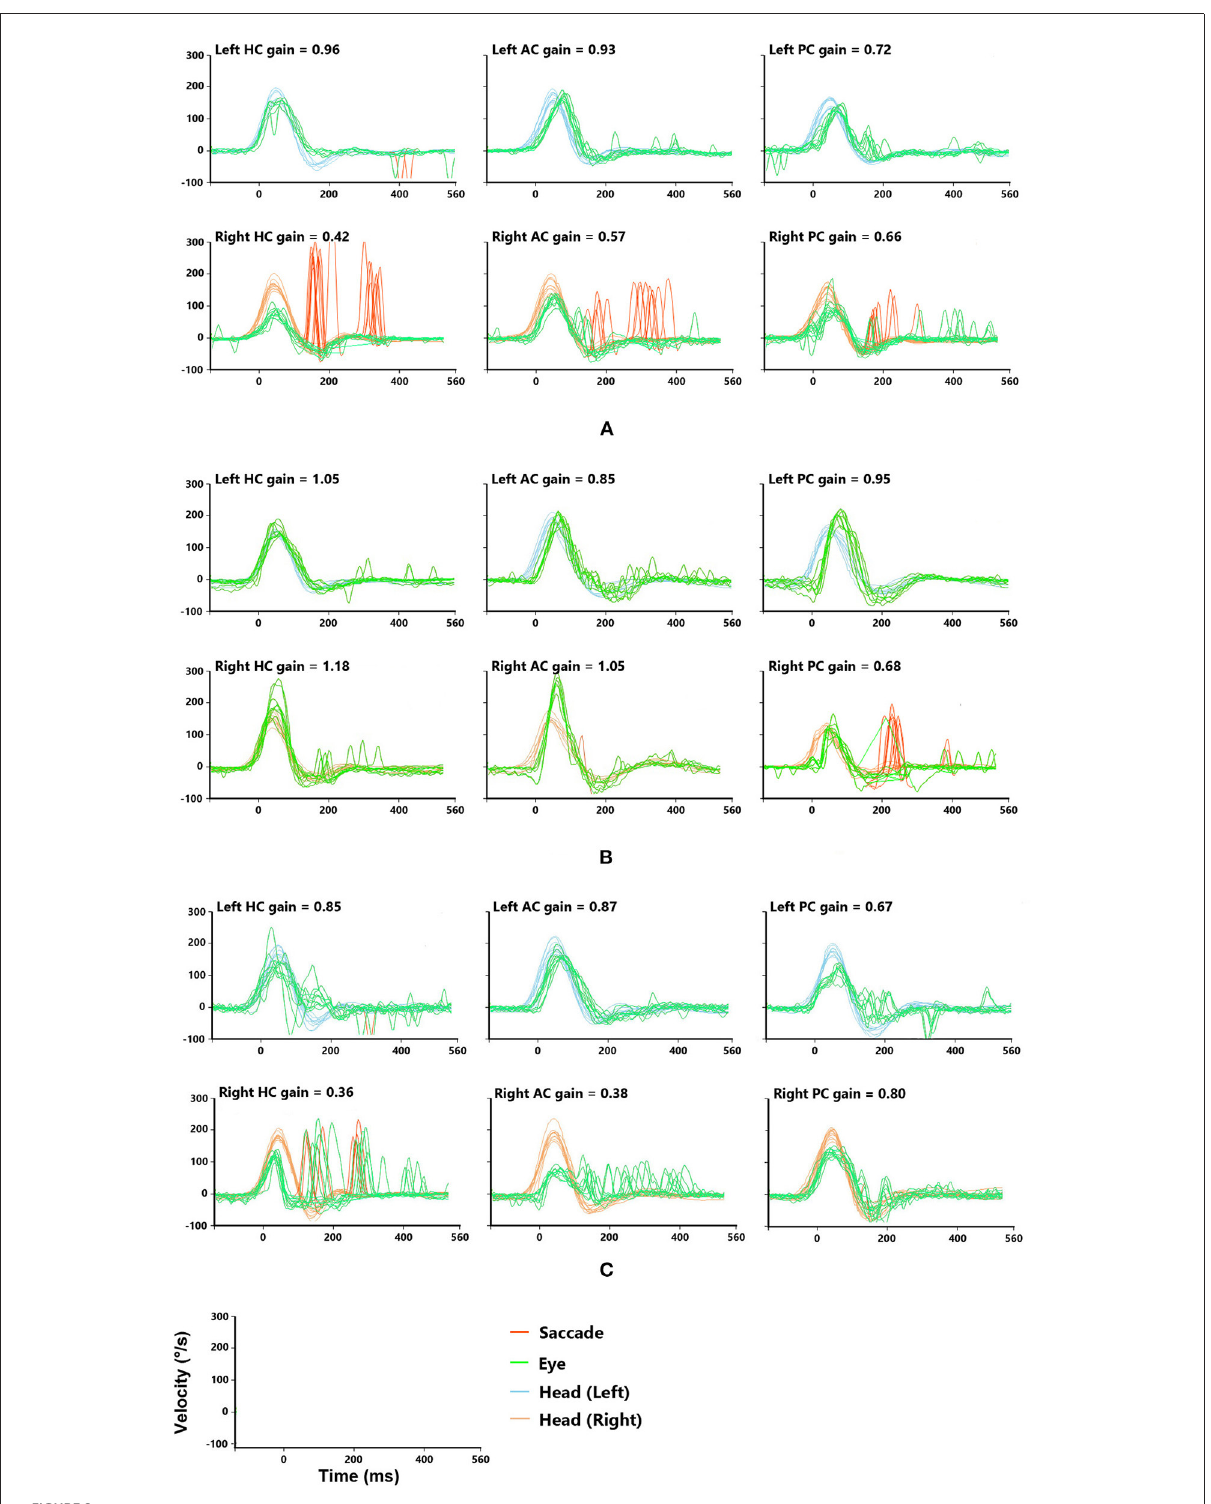
FIGURE2 Typical vHITs images recorded from patients with episodic vertigo. The sample coordinates (last row) indicate the units of vHITs. (A) A patient with damaged superior and inferior vestibular nerves. The vHITs findings showed decreased VOR gains and corrective saccade for the right horizontal semicircular canal (HC) and vertical semicircular canals, including anterior and posterior semicircular canal (AC and PC). (B) A patient with damaged inferior vestibular nerve. The vHITs findings showed decreased gains in VOR for the right PC, while that for right the AC and HC was normal. (C) A patient with damaged superior vestibular nerve. The vHITs findings showed decreased gains of VOR for the right AC and HC. The VOR for right PC was